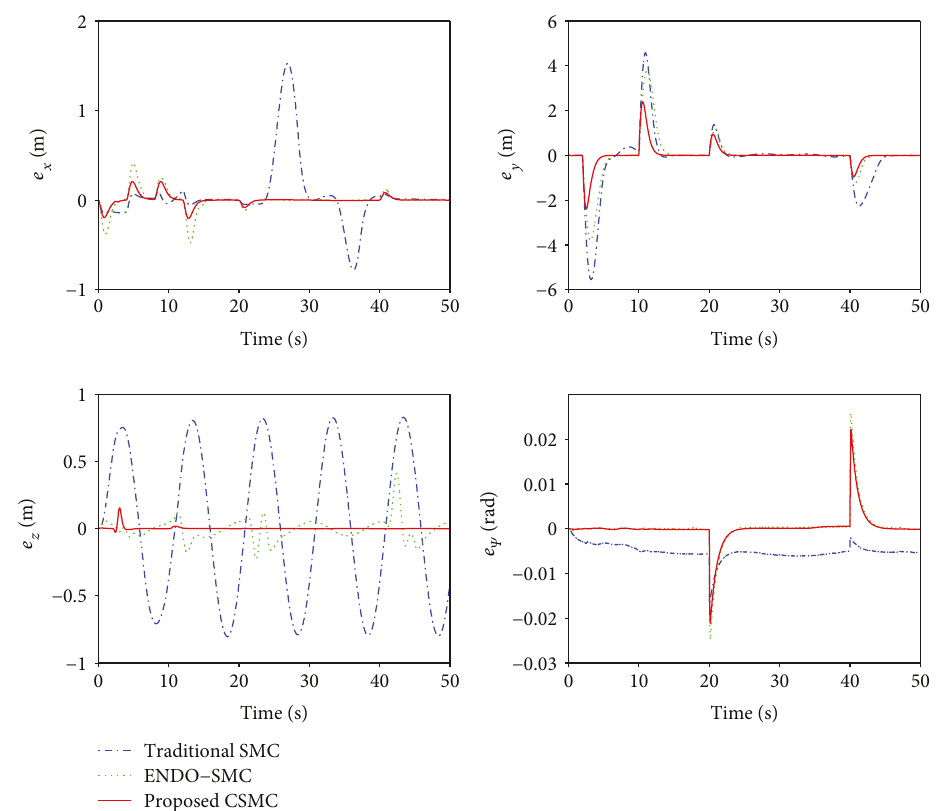
Figure 9: The response curves of tracking errors of maneuver.